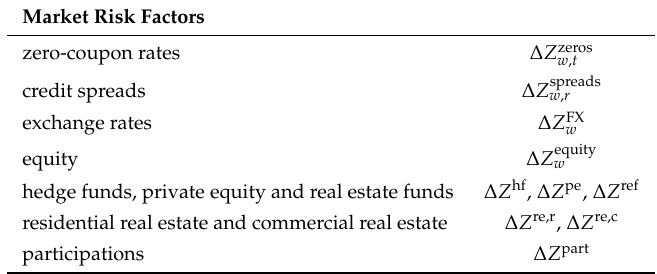
Table 2. Market risk factors considered, including the notation for their changes. The lower indexes run over maturity buckets t ∈ T , currencies w ∈ C and ratings r ∈ R ,